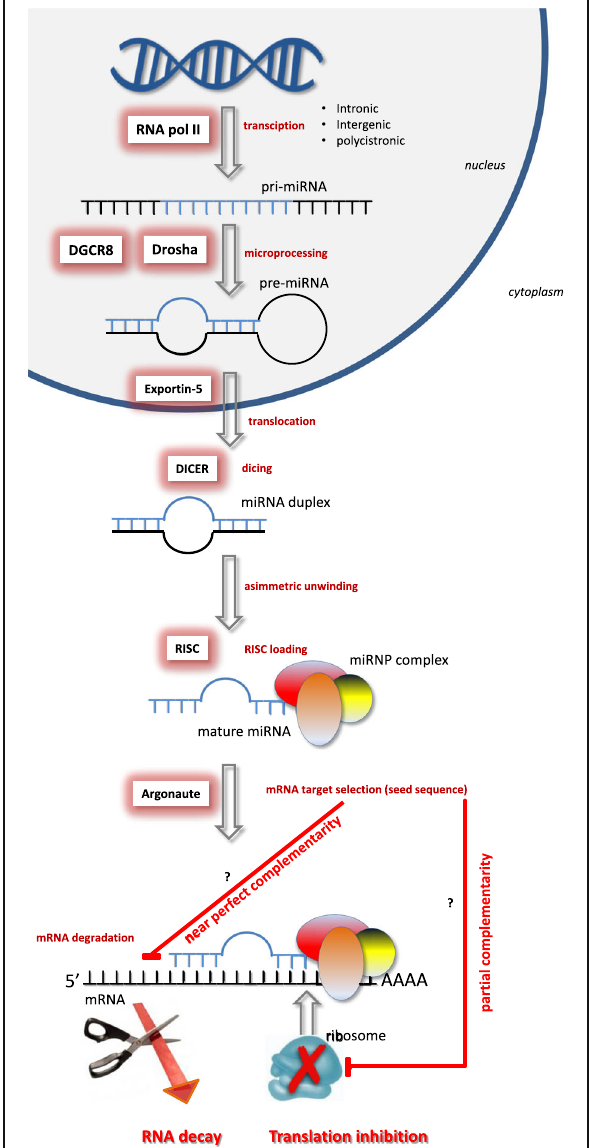
Fig. 1 miRNA biogenesis. Single miRNAs are transcribed by RNA polymerase II (pri-miRNA) from genomic DNA. The pri-miRNA is processed to pre-miRNA by Drosha-DGCR8. The pre-miRNA is transferred to the cytoplasm by exportin-5 where it is recognized and cleaved by the DICER complex to create a miRNA duplex. The duplex unwinds, and the mature miRNA assembles into RISC. The miRNA base-pairs with target mRNA determines gene silencing via mRNA cleavage or translation repression depending on the degree of homology between the miRNA “ seed ” to the 3 ′ UTR target se- quence of the